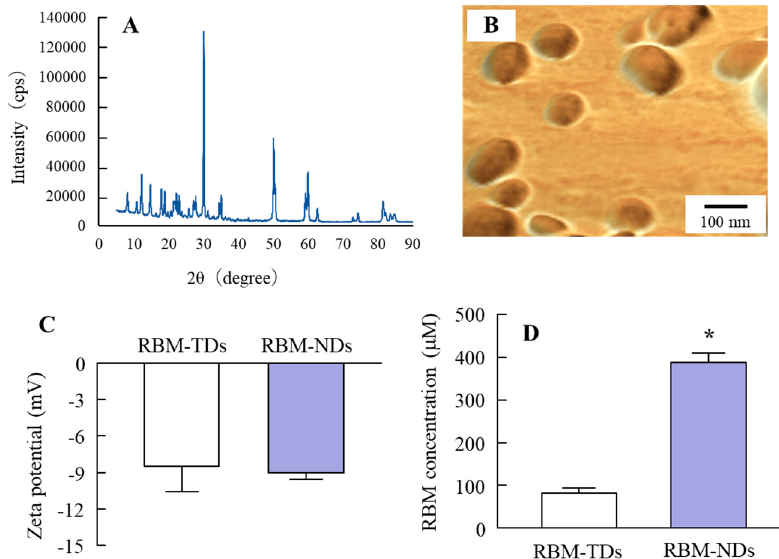
Figure 1. Changes in particle size by nanonization of rebamipide (RBM) using the bead mill treatment. Particle size frequencies (solid line, green) and cumulative distribution (dashed line, blue) of RBM in traditional RBM powder (RBM-TDs) ( A ) and RBM solid nanocrystals (RBM-NDs) ( B ) as determined by a laser diffraction particle size analyzer. ( C ) Particle size frequencies of RBM in RBM-NDs by the dynamic light scattering method. ( D ) Atomic force microscopy (AFM) image of RBM in RBM-NDs (wide-field). The scale of depth and width are 15 μ m. These experiments were repeated six times. The RBM particle size in RBM-NDs was in the range of 30–190 nm.